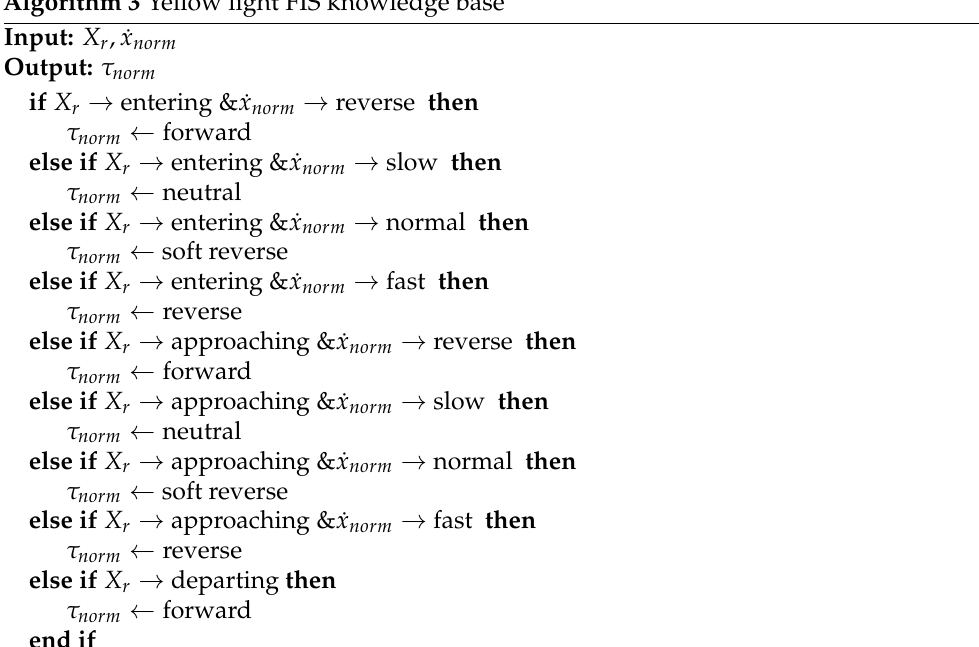
Figure 5. Yellow fuzzy sets. Algorithm 3 Yellow light FIS knowledge